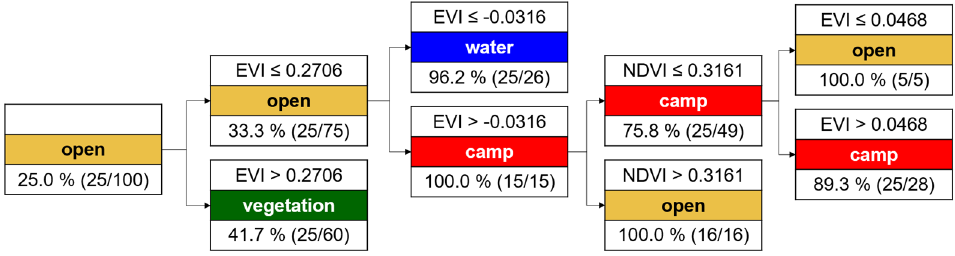
Figure A10. CART for January 2019.